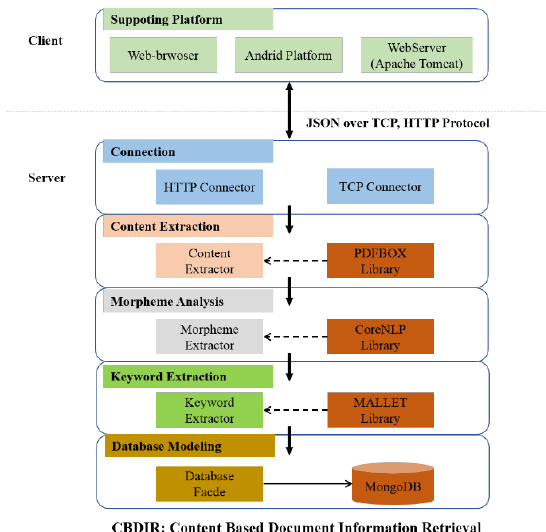
Fig. 1. The system structure of